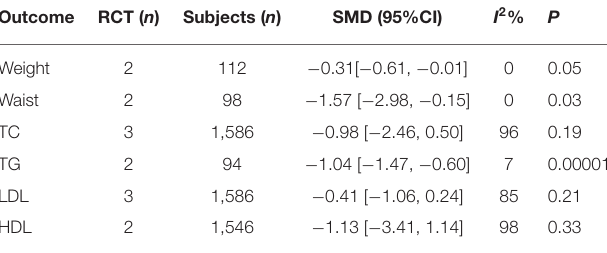
TABLE 2 | Effect of the modified DASH diet in adults with increased BP for cardiovascular risk factors.